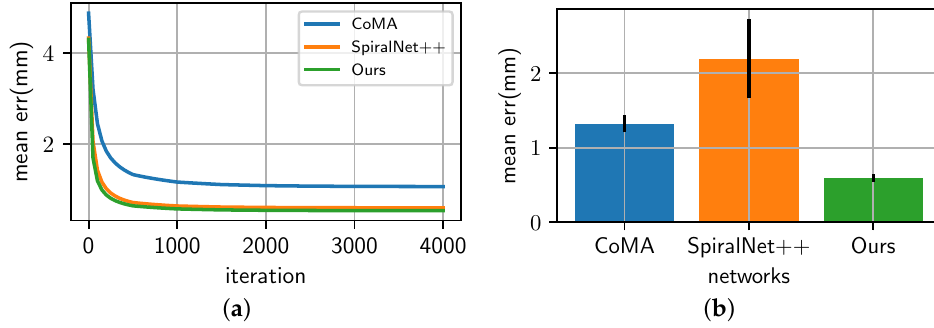
Figure 8. ( a ) This figure shows that our neural network system accomplishes faster convergence of the network optimization with fewer errors for the shape completion when compared with other neural network systems. ( b ) Our system achieves lower variance and errors than other neural network systems for the shape denoising task. All the errors are measured in millimeters.